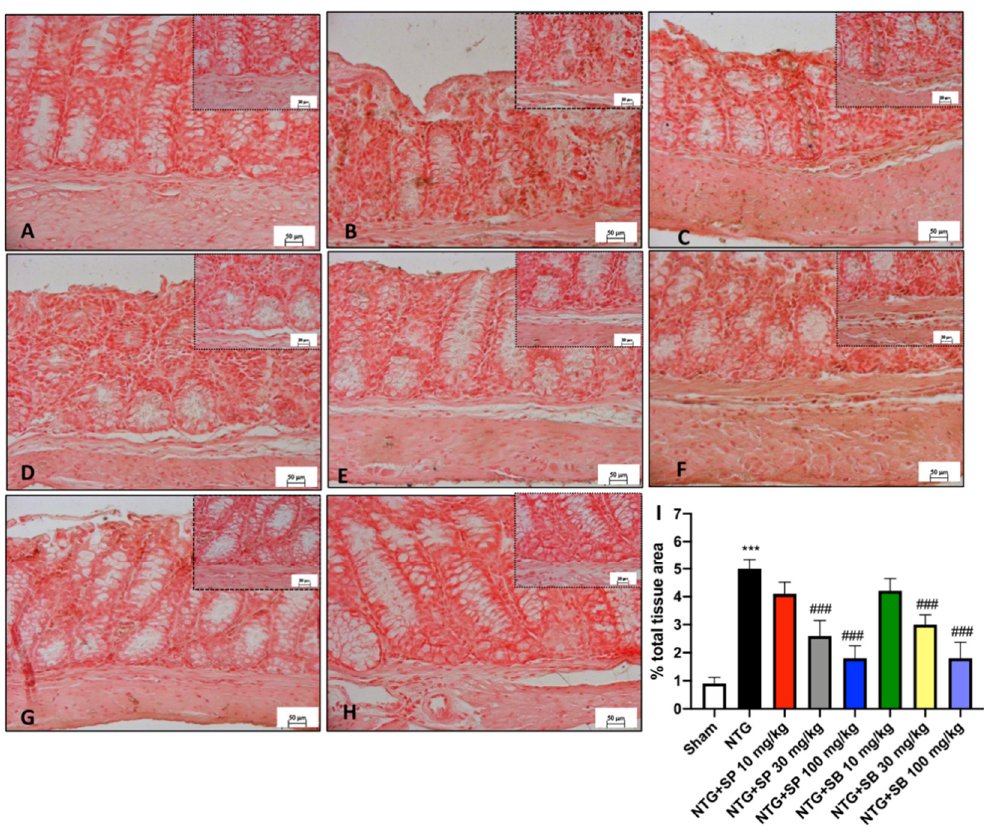
Figure 7. Effect of SCFA administration on nNOS expression in the intestine of NTG-injected mice. A marked positive staining of nNOS is detected in NTG mice ( B , I ) compared to the sham group ( A , I ). nNOS expression is significantly reduced in SCFA-treated animals at the two highest doses ( D , E , G , H , I ). Treatment with SCFAs of 10 mg/kg do not show any considerable reduction of nNOS expression ( C , F , I ). Data are representative of at least three independent experiments; one-way ANOVA test. *** p < 0.001 vs. sham; ### p < 0.001 vs. NTG. N = 10 mice/group for each technique.